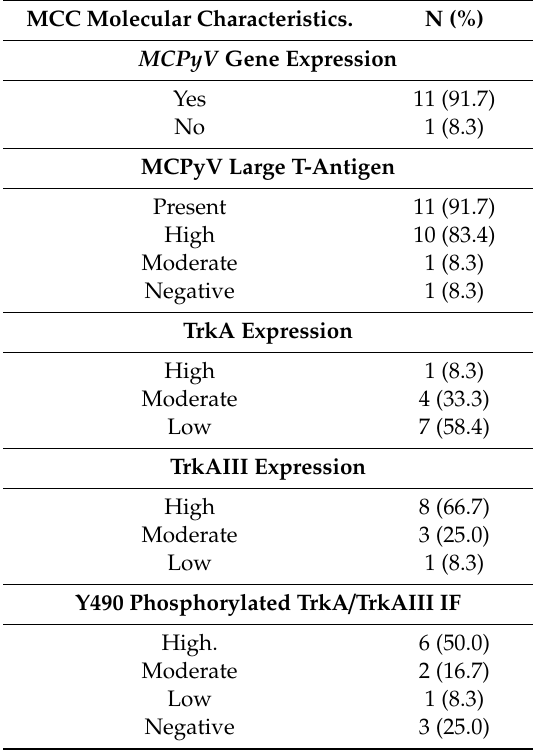
Table 3. Molecular characteristics of MCC patients. MCC Molecular